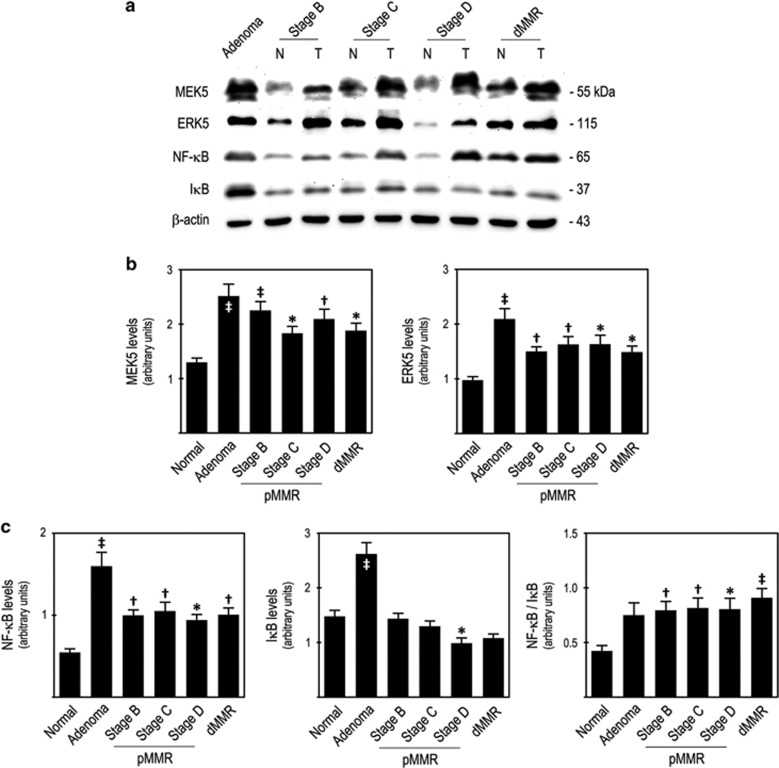
MEK5/ERK5 and NF-κB signalling pathways are deregulated in human CC, with ERK5 expression correlating with increased NF-κB activation. (a) Representative immunoblots of steady-state protein expression levels of MEK5, ERK5, NF-κB, IκB and β-actin in normal colon, colon adenomas and pMMR and dMMR colon carcinomas; (b) MEK5 and ERK5 steady-state protein levels; (c) NF-κB, IκB and NF-κB/IκB ratio; (d) correlations between ERK5 steady-state protein levels and NF-κB, IκB or NF-κB/IκB ratio; (e) representative immunoblots of steady-state levels of p-NF-κB, NF-κB, p-IκB, IκB and β-actin in normal colon, colon adenoma, and pMMR and dMMR colon carcinomas; and (f) representative immunohistochemistry for ERK5, p-NF-κB and NF-κB in human colon cancer samples. Immunoblot statistical significance was determined using the non-parametric statistical analysis Kruskal–Wallis test with Dunn's post test for selected comparisons and results are expressed as mean±S.E.M. for samples in each category; correlation statistical significance was determined using the non-parametric stastistical analysis Spearman test. pMMR, proficient mismatch repair system; dMMR, deficient mismatch repair system. Scale bar=100 μm. *P<0.05, †P<0.01 and ‡P<0.001 from normal colon